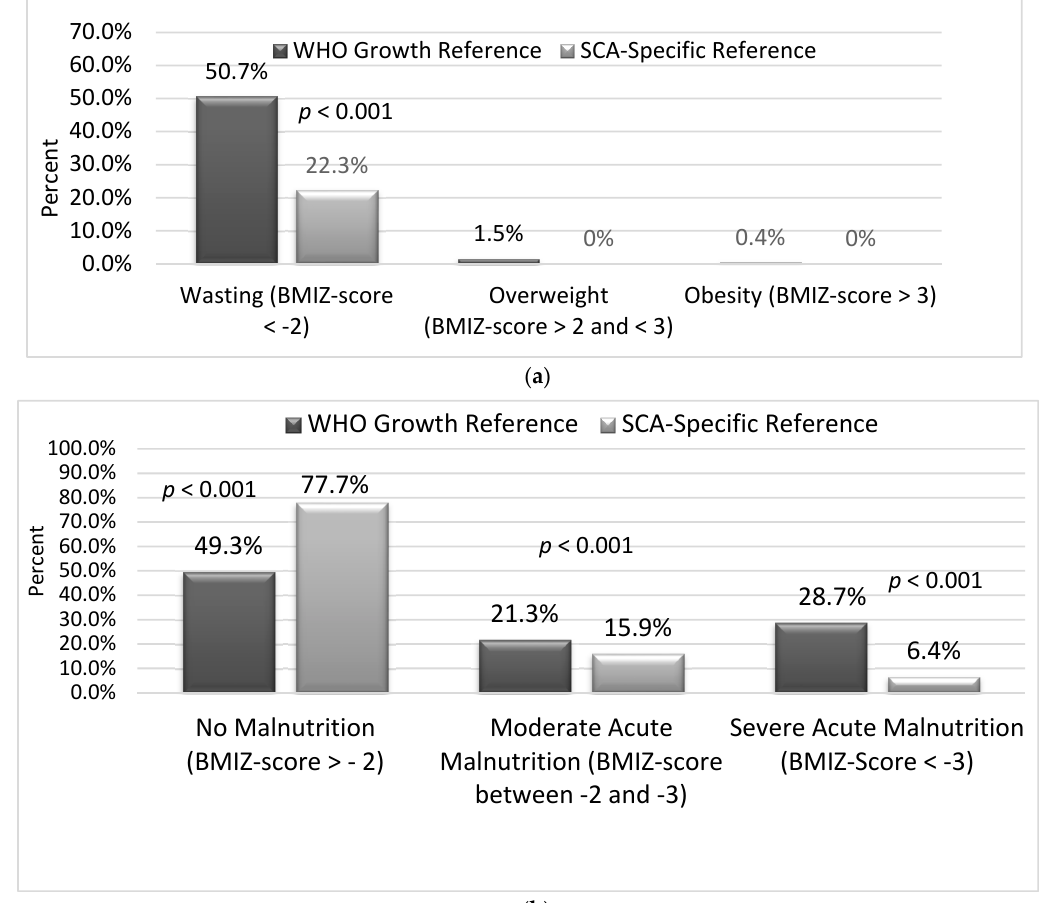
Figure 2. Proportion of children with sickle cell anemia (SCA) with malnutrition according to World Health Organization (WHO) and SCA-specific growth references. ( a ) Proportion of children with SCA defined as wasting, overweight, or obesity based on two reference populations. Using the WHO growth reference in children (5–12 years of age) with sickle cell anemia (SCA) living in northern Nigeria misclassified the prevalence of wasting when compared to the SCA-specific growth reference.